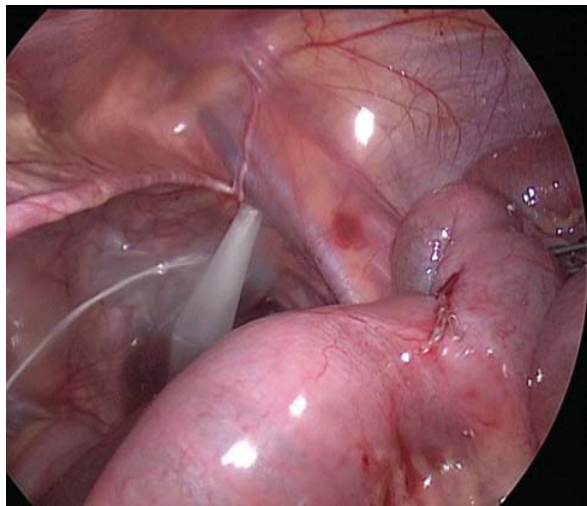
Fig. 4 BowelafterMDresectionwithEndoGia.MD,Meckel ’